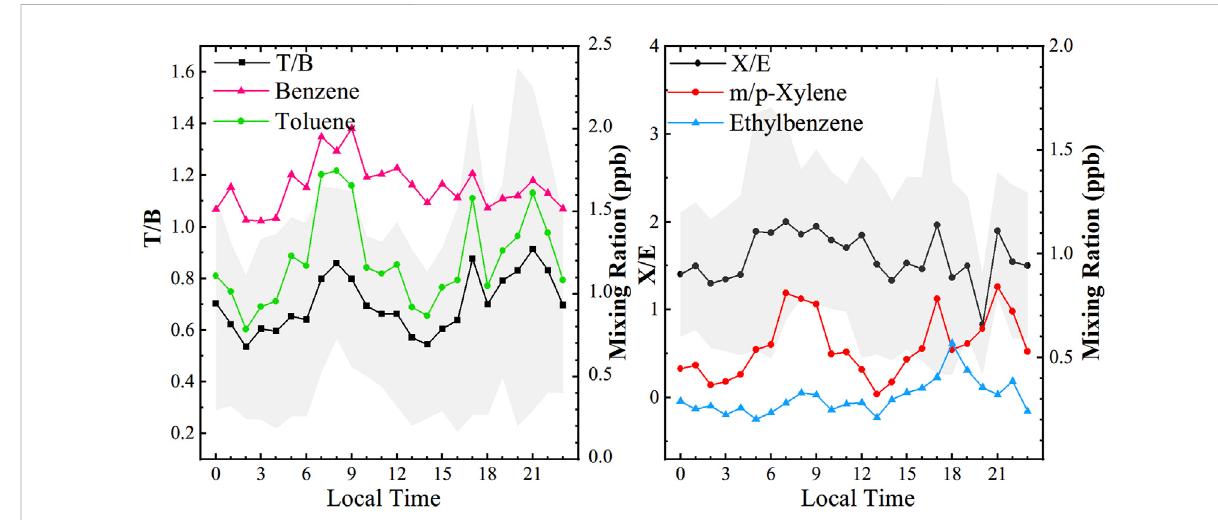
Average diurnal variations in benzene, toluene, m/p-xylene, and ethylbenzene mixing ratios and T/B and X/E